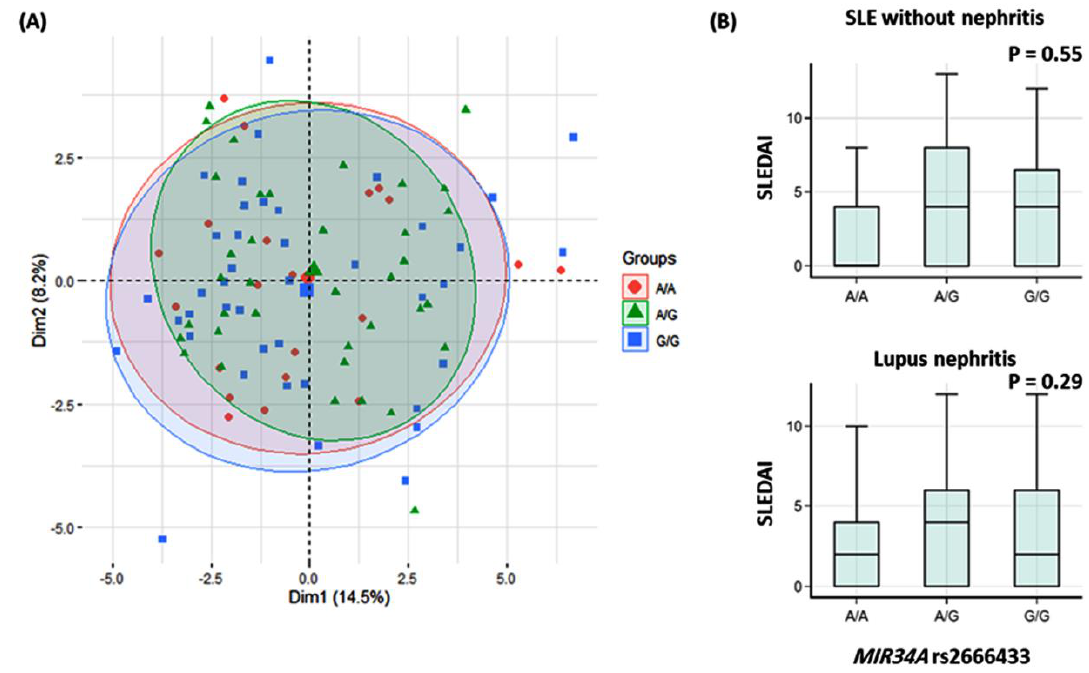
Figure 3. Impact of MIR34A rs2666433 (A/G) variant on disease activity index. ( A ) The principal component analysis for data exploration showed no clear demarcation between patients with different genotypes. ( B ) Box plots in SLE with and without nephritis show no significant difference in SLE disease activity index (SLEDAI).